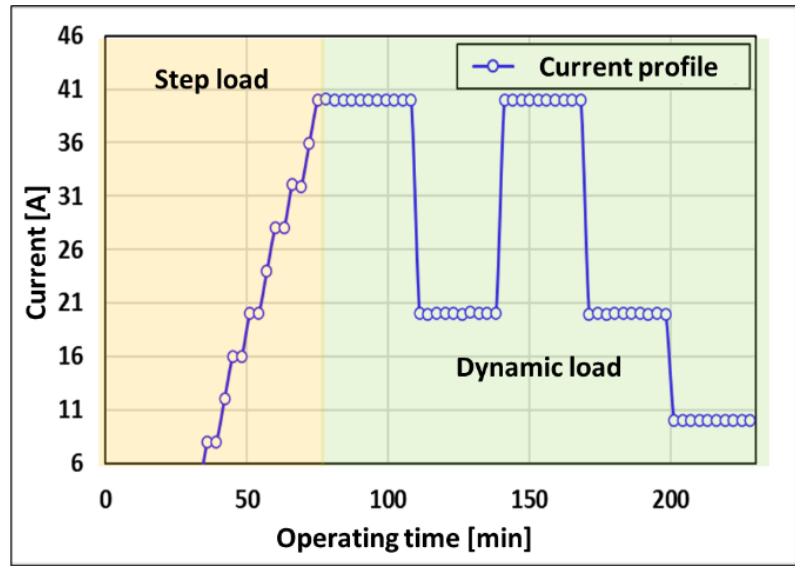
Figure 9. Current profile for the HILS system.